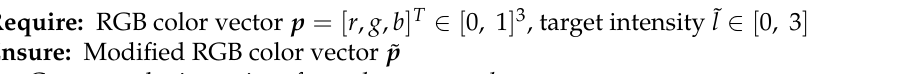
Algorithm 1 Naik and Murthy’s